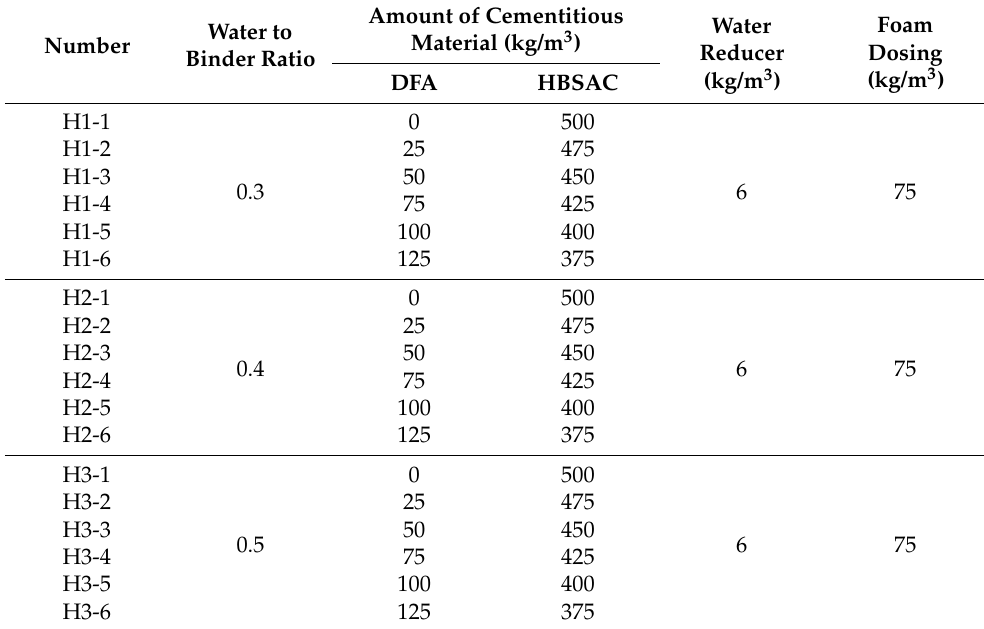
Table 6. Foam concrete mix ratio design table.